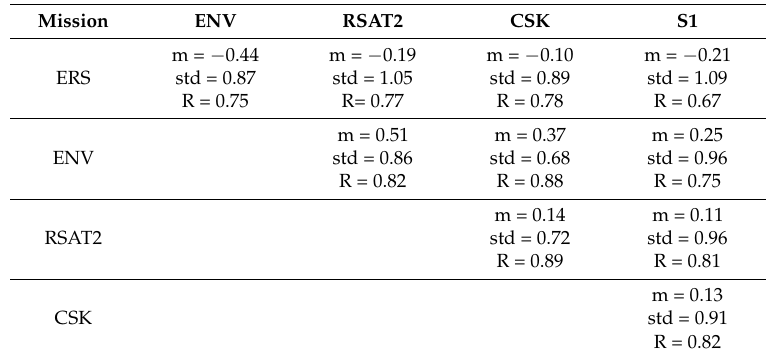
Table 4. Mean (m), standard deviation (std) and correlation coefficient (R) of the difference between velocities from the different datasets in Figure 3.